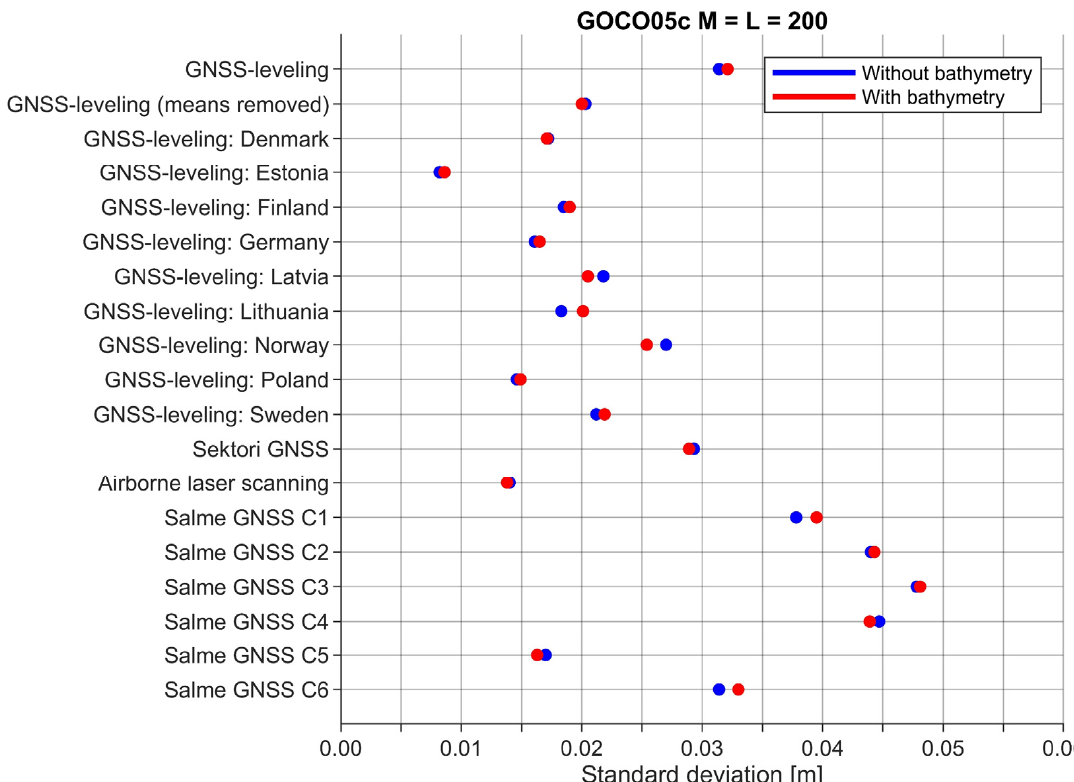
J. Mar. Sci. Eng. 2022 , 10 , x FOR PEER REVIEW 22 of 27 Figure 17. Validation results of gravimetric geoid models. GGM: GOCO05c, modification limits: 200.